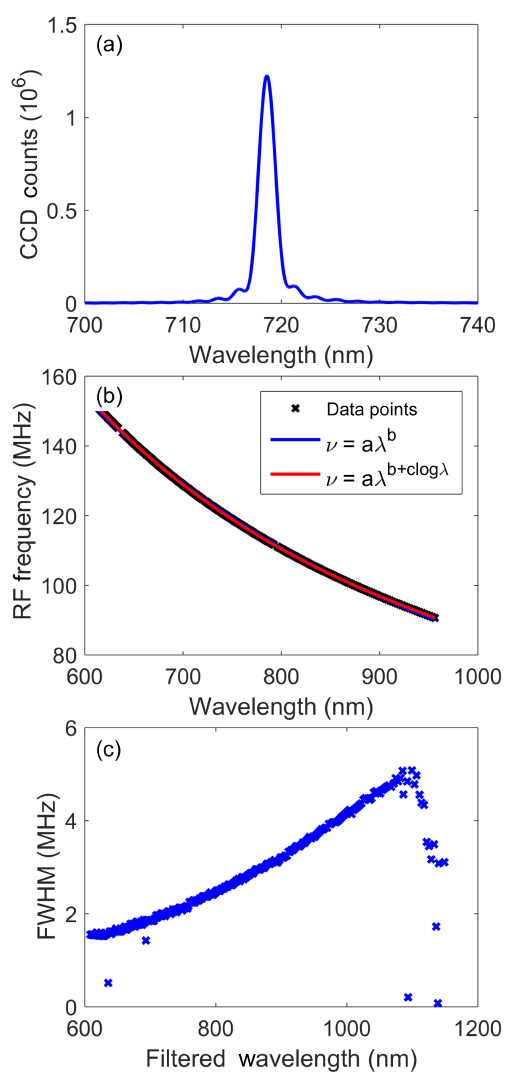
Figure 6. (a) A spectrum taken from the AOTF from the point spread function when the tuning frequency of the AOTF was at 124.96MHz. (b) The calibration curves for the AOTF tuning curve which contains the data points recorded and fit curve. (c) The full width half maximum for each of the determined wavelengths for the AOTF. The full width half maximum at 600nm is 1.5nm and as the wavelengths get longer it increases to 4.9nm at